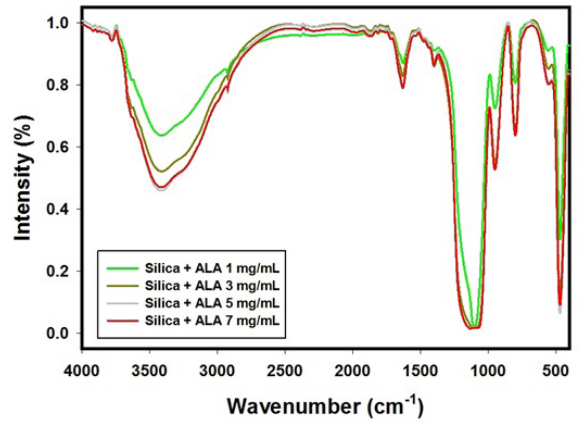
Figure 3: FT-IR spectra of silica after Amano Lipase A